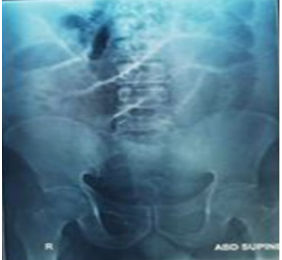
Fig. 1: Plain X-ray abdomen: Supine: Showing distended bowel loops.